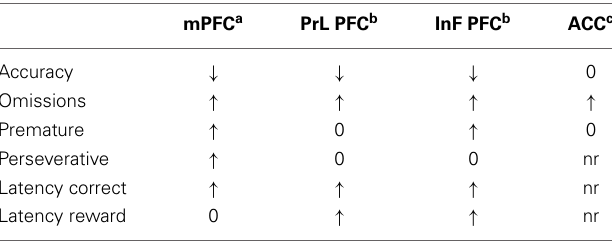
Table 1 | Effects of blockade of frontocortical NMDA receptors on attentional